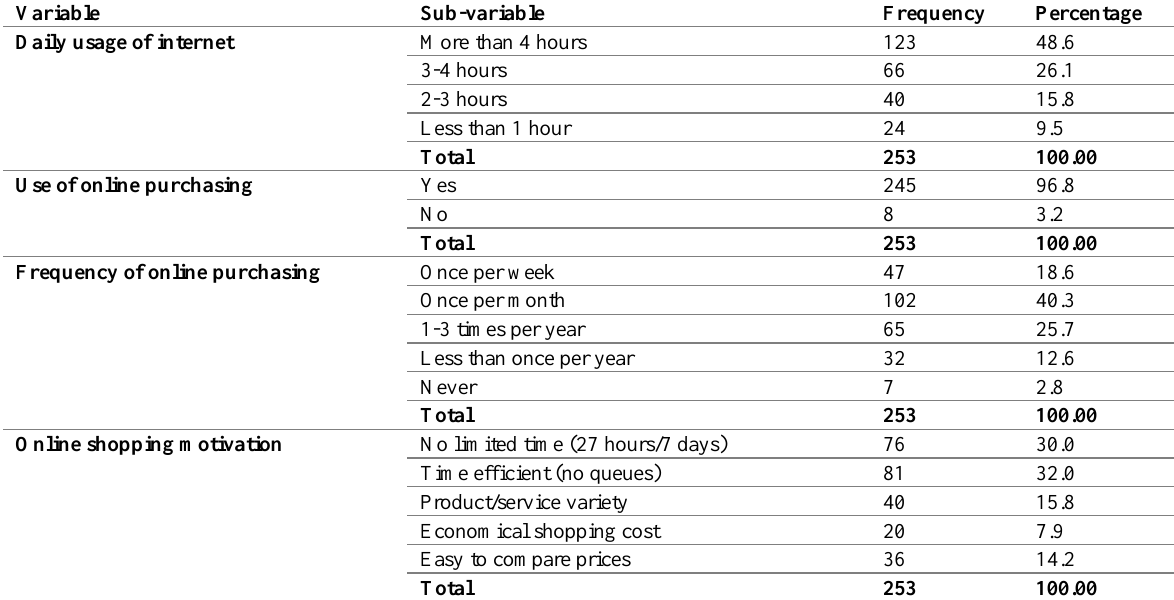
Table 2: Customer Online Activity